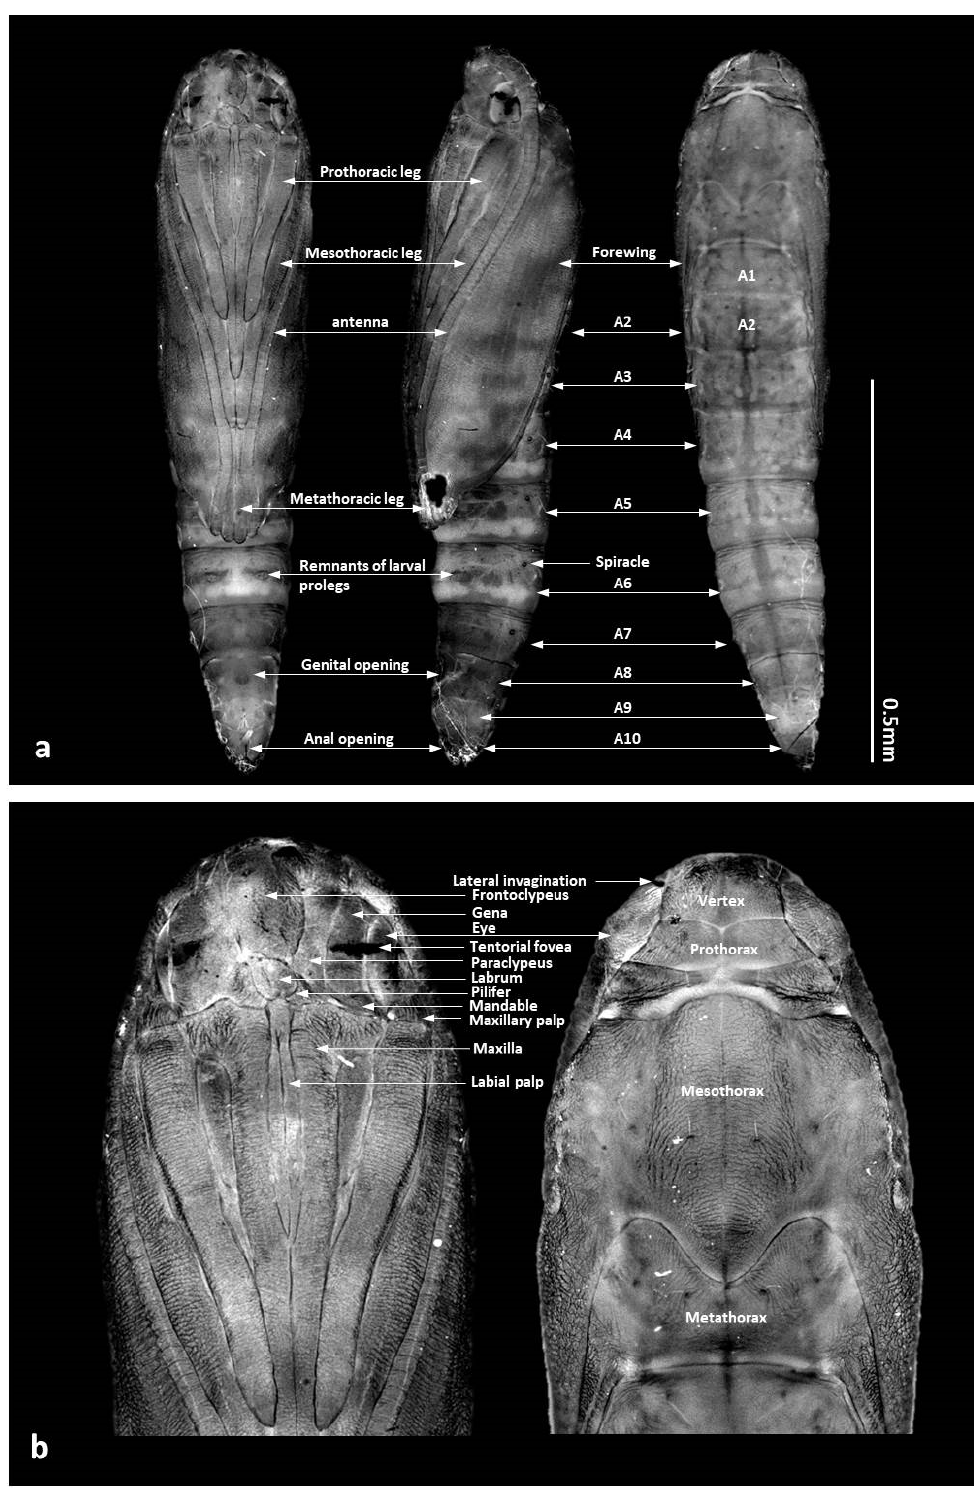
Figure 4. Pupa of Yponomeuta meguronis : ( a ) ventral, lateral, and dorsal views; ( b ) caput.